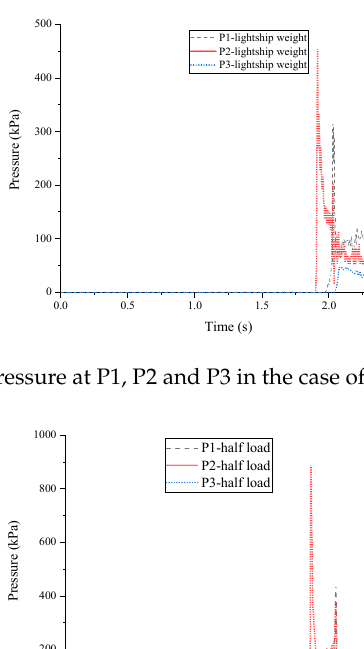
Figure 11. Slamming force of the bow at each loading condition .